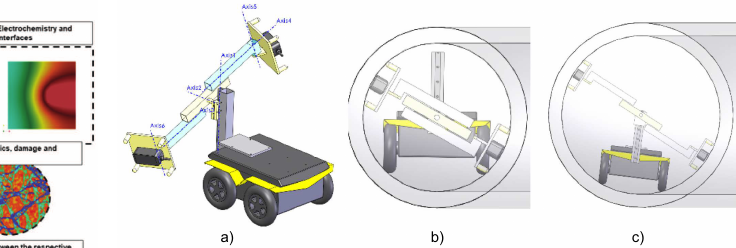
Fig. 8. (a) Concept of robotic solution design, (b) and (c) its deployment in a pipe with regard to the diameter.